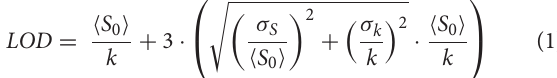
the l parameter ( Table 3 ) are in agreement (within 1 SD) with the number of counts measured for the unirradiated samples ( Table 1 ), which supports the reliability of fitting curves.